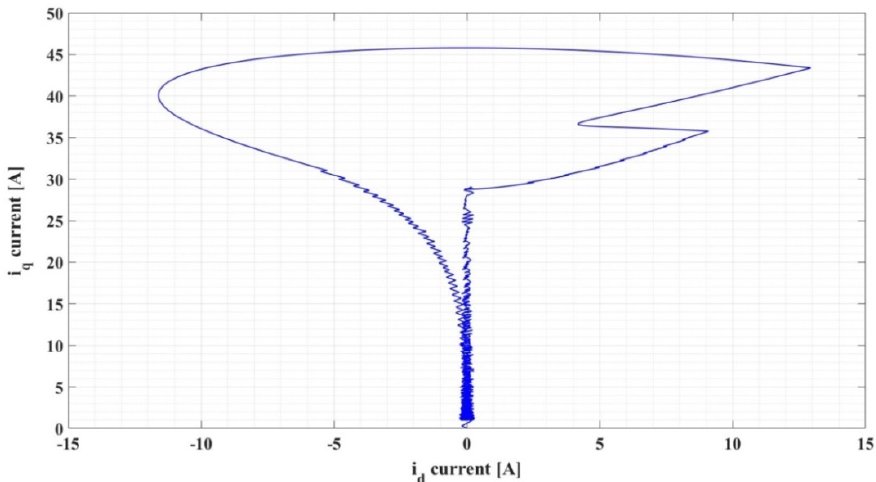
Figure 4. Image of the phase plan: i q current versus i d current.